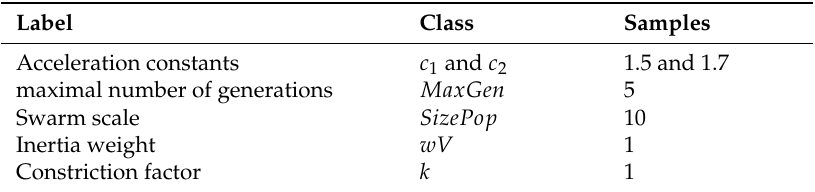
Table 2. Parameter settings for the PSO